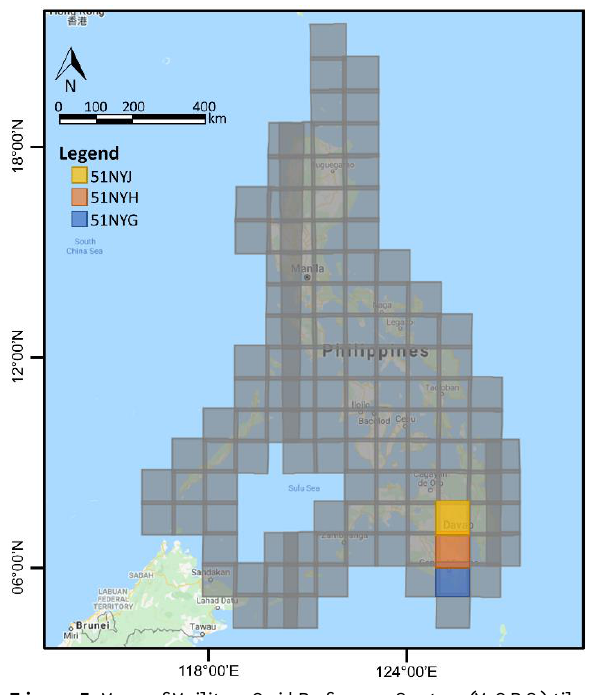
Figure 5 . Map of Military Grid Reference System (MGRS) tiles in the online Mangrove Vegetation Index (MVI) Mapper with unaccounted mangroves in the 2019 Mangrove Extent Map of the Philippines produced using MVI.